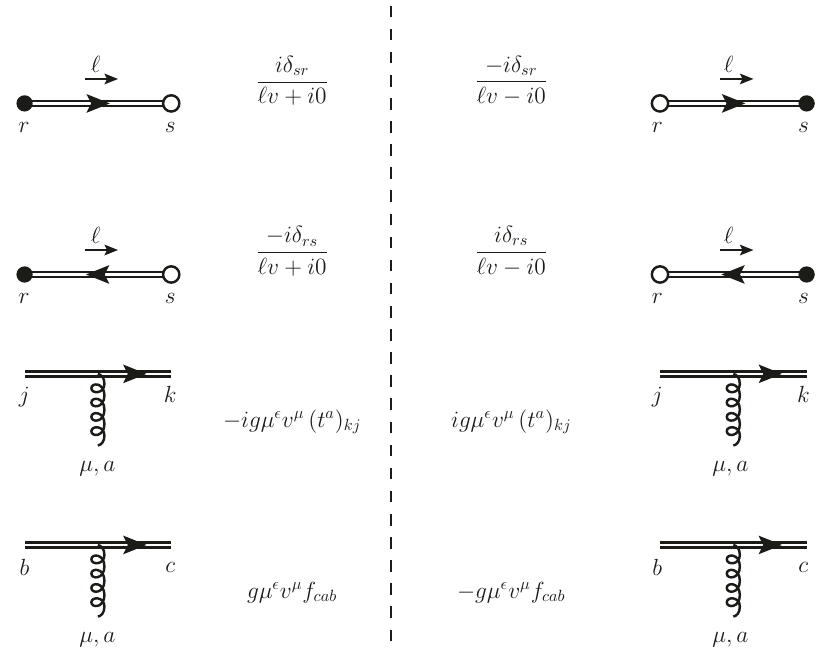
Figure 13. Feynman rules involving eikonal lines along the direction v . The colour indices r and s refer to either the fundamental or the adjoint representation, whereas j and k are colour triplet and a , b and c are colour octet indices.